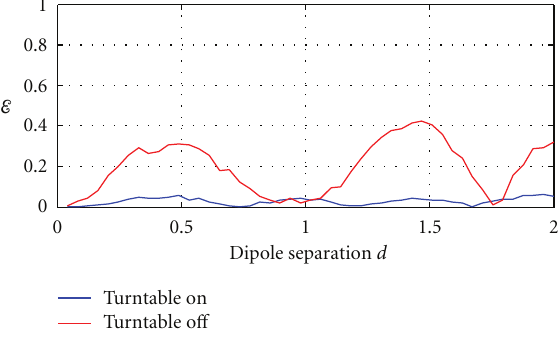
Figure 13: The error E as a function of dipole separation d for the small chamber with dimensions D x = 1m, D y = 0 . 9m, and D z = 0 . 8m operating around